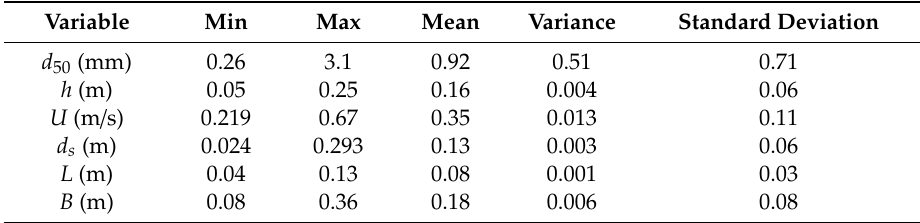
Table 1. Statistical indices for the collected